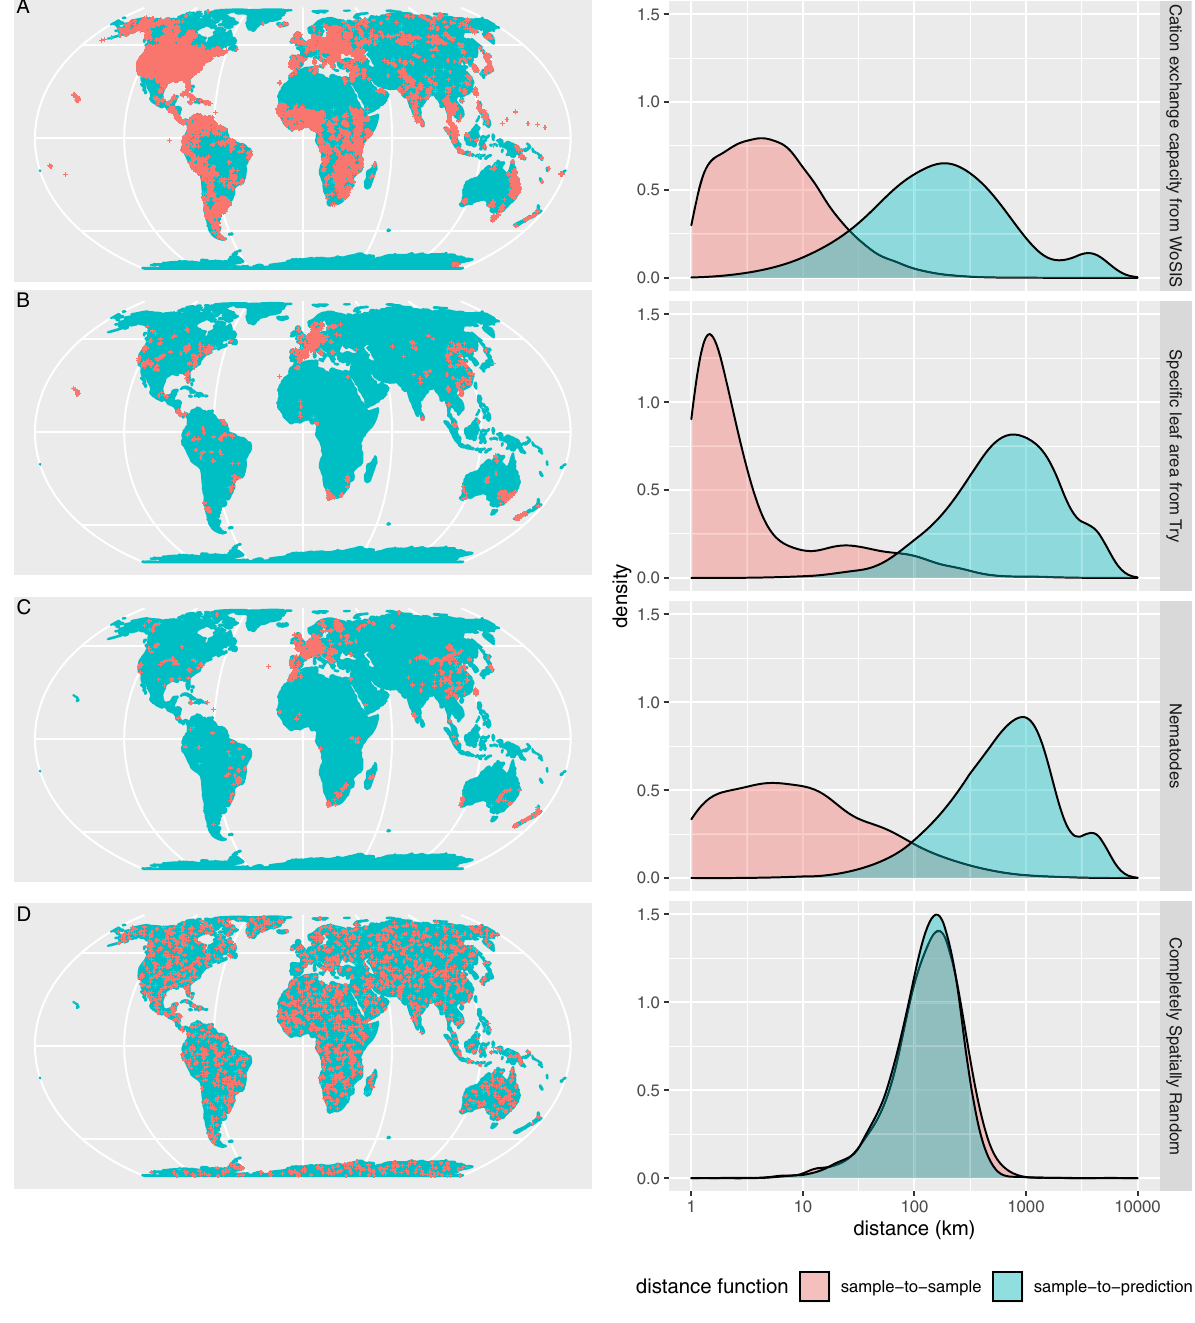
Fig. 1 Spatial distance distributions in global mapping studies. Spatial distribution (left; equal Earth projection) and distribution of nearest neighbor distances (right; sample-to-sample distance in pink, prediction-location-to-sample distance in blue) for three different publicly available datasets: cation exchange capacity in the soil from the WoSIS database 23 as used for global soil mapping 3 ( A ), speci fi c leaf area from the Try database 24 as used for the global mapping in Moreno-Martinez et al. (2018) 25 ( B ), and the nematodes dataset compiled by Van den Hoogen et al. (2019) 2 ( C ). For comparison, the fourth dataset is a simulated completely spatially random sample of the same size as the nematode dataset ( D ). Distance distributions were calculated and visualized using the R package “ CAST ” 26